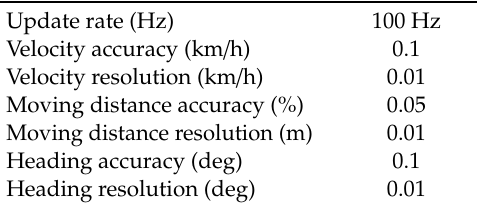
Figure 11. Experimental setup for steering pull measurement .